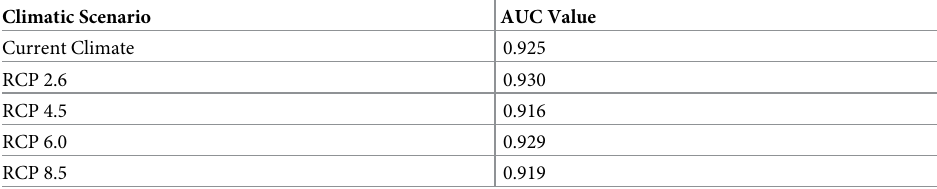
Table 4. The AUC values for the five Bactrocera zonata climatic suitability models run in MaxEnt. Climatic